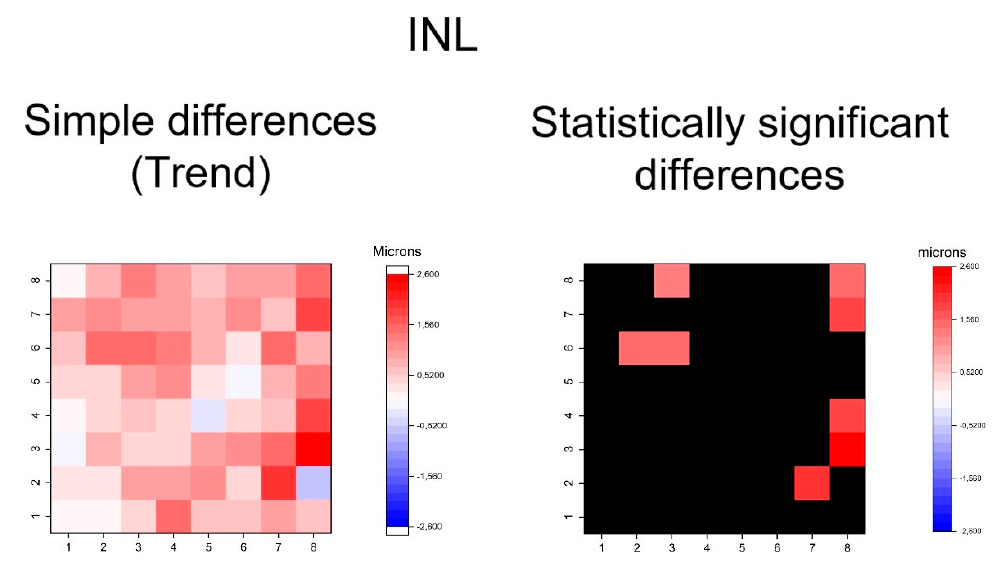
Figure 7. Heatmaps showing differences in inner nuclear layer (INL). Left map: this heatmap represents simple differences of mean thickness between OHT group and early POAG group in each superpixel giving an idea of the trend. Right map: the heatmap represents statistically significant differences ( p < 0.05) of the mean thickness between groups in each superpixel. No significant difference ( p ≥ 0.05) is represented in black. Range of significant OHT ‐ POAG differences in superpixels between 1.33 and 2.52 microns.